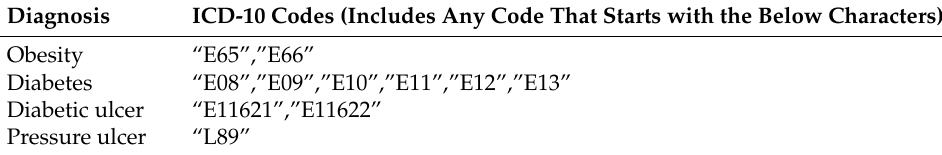
Table A1. Cont. ICD-10 Codes (Includes Any Code That Starts with the Below Characters)